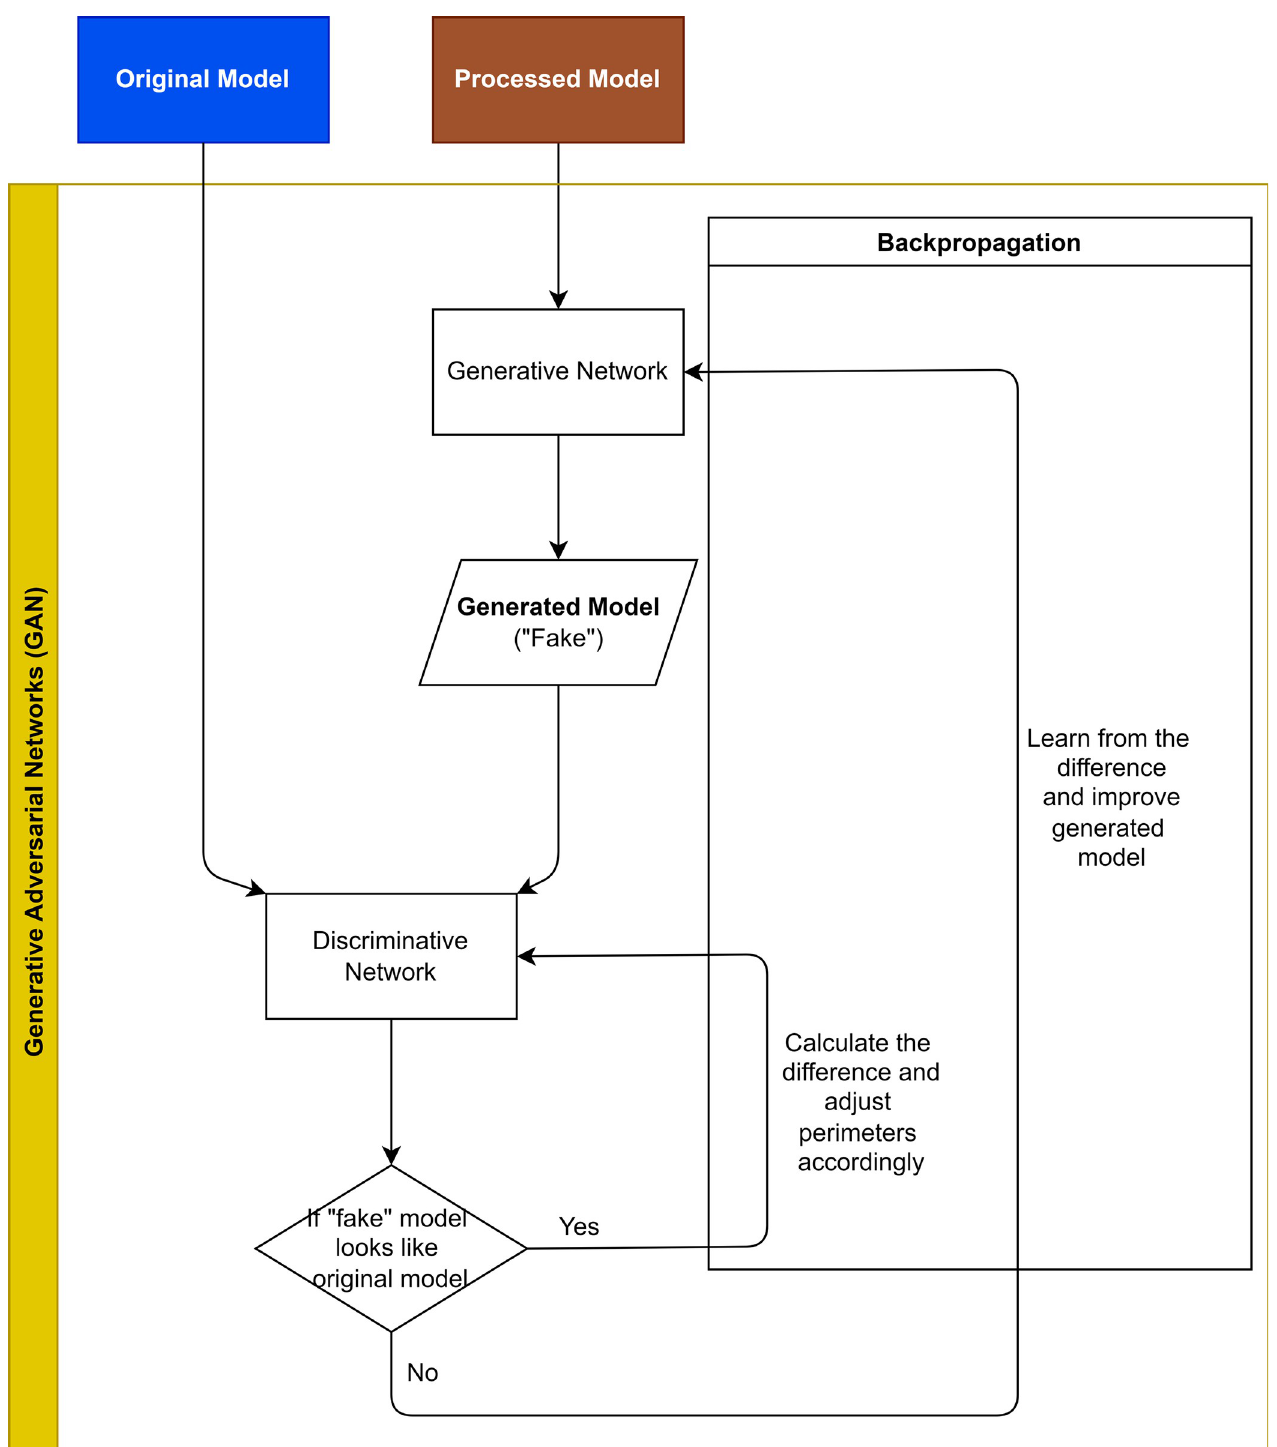
Fig 3. Brief architecture of the Generative Adversarial Network (GAN) of this study. Original model: digitized maxillary teeth model collected from participants; processed model: teeth model with tooth 16 removed; Generated model: teeth model with AI-generated tooth 16.